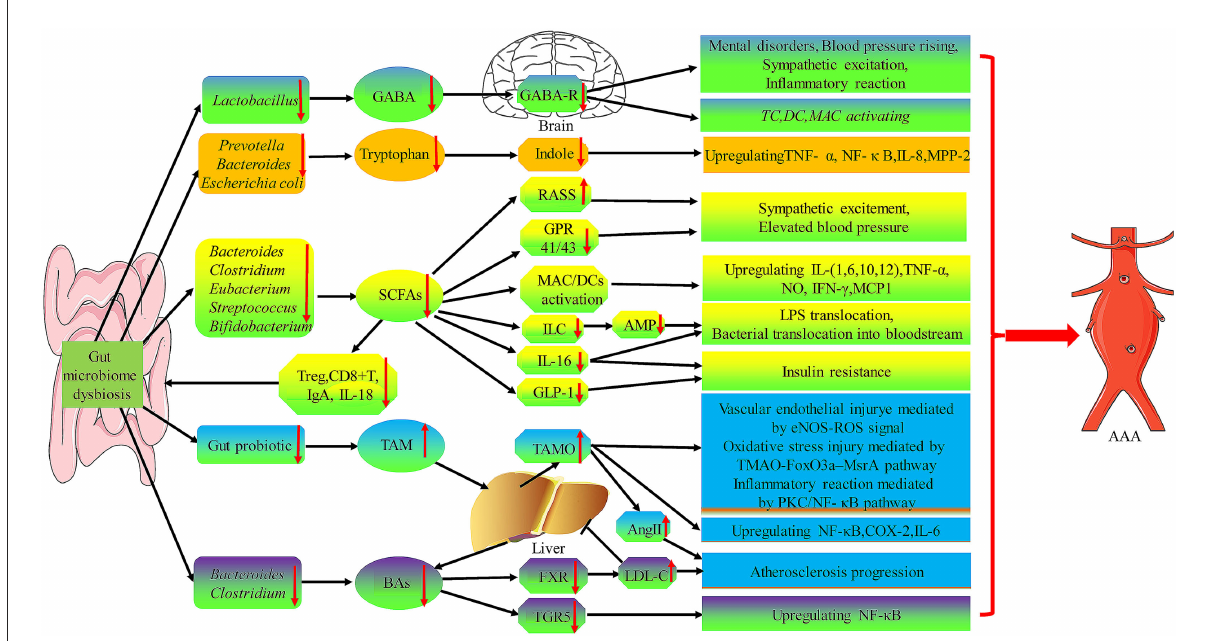
FIGURE4 The role of gut microbiota metabolites in the pathogenesis of AAA. Gut microbiome dysbiosis cause the decrease of GABA, Tryptophan, and SCFA produced by certain specific flora, while the increase of TAM and BAs production, which will lead to TC, DC, MAC activating and upregulation of many inflammatory factors (i.e., TNF- α , NF- κ B, IL-1, IL-6, IL-8,IL-12, and MPP-2) to promote AAA formation and progression. GABA, γ -aminobutyric acid; AMP, antimicrobial peptides; GPR, G protein-coupled receptor; ILC, innate lymphocytes; RAAS, renin-angiotensin-aldosterone system; FXR, farnesoid X receptor; TGR5, G-protein-coupled bile acid receptor-1; TMA,